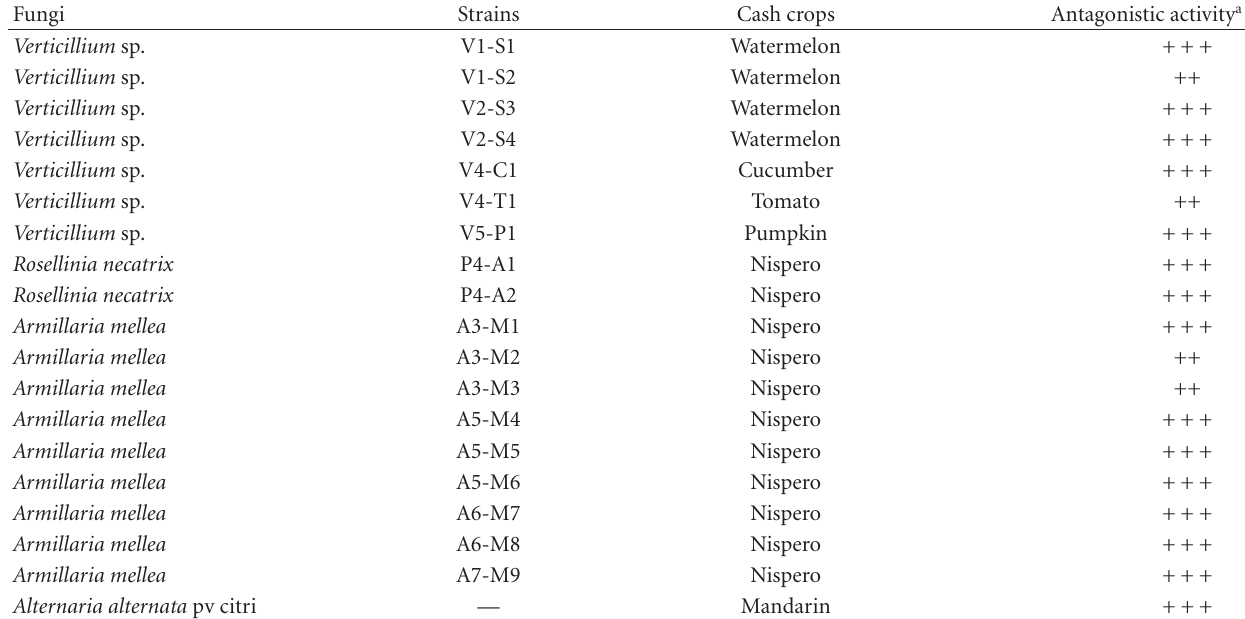
Table 2: Inhibitory activities of B. subtilis 21 against pathogenic fungi isolated from Spain cash crops. Fungi Verticillium